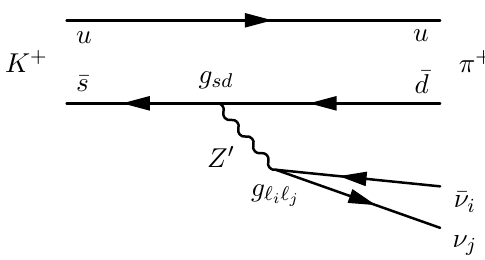
Figure 8 . Leading order Z 0 contribution to the decay K + ! (cid:25) + (cid:23) (cid:22) (cid:23)